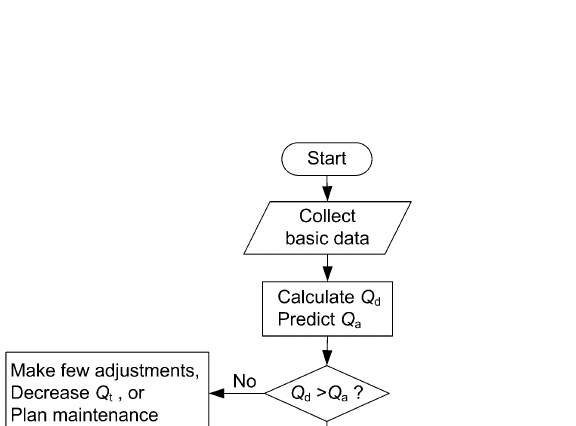
Table 1 Relevant parameters of the Heidaigou surface mine from 2007